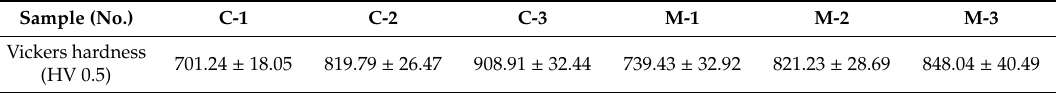
Table 5. Vickers hardness of glass-ceramics produced by conventional and microwave heating.